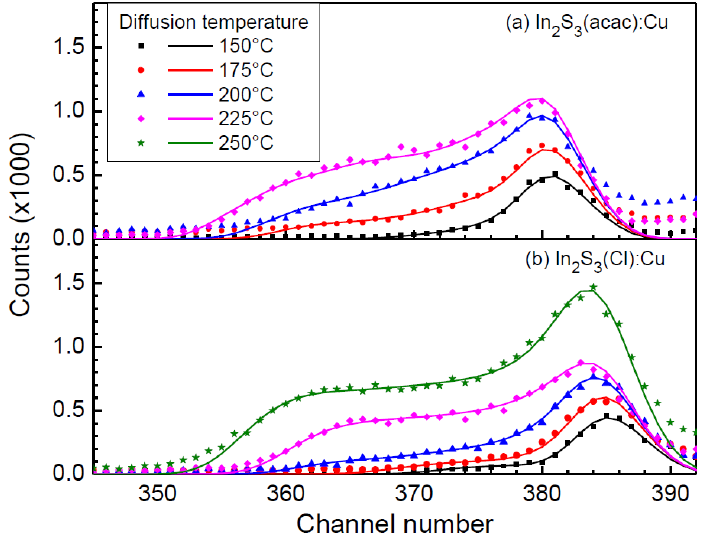
Figure 2. Cu peaks for ( a ) In 2 S 3 (acac):Cu and ( b ) In 2 S 3 (Cl):Cu for different diffusion temperatures. The scatters represent measured data while the solid lines are from simulation.